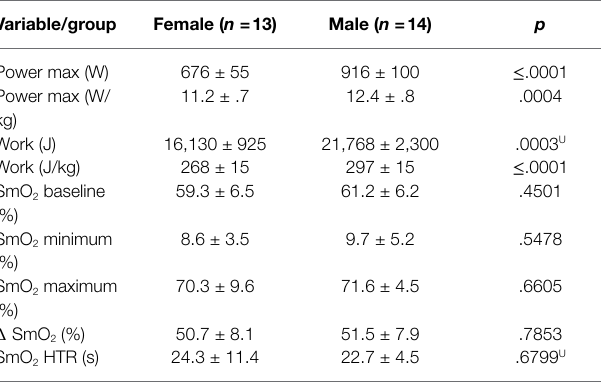
( Table 5 ), and test duration ( r = − .46, p < .05), ( Figure 2 ).